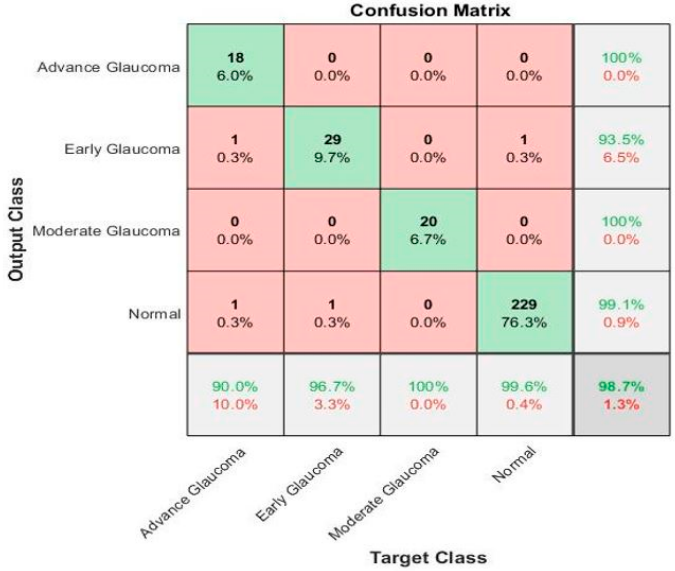
Figure 6. Confusion matrix of the 4-class glaucoma classification using the proposed ML-DCNN model on the Testing Dataset. Table 5. Computed Values (%) of Statistical Measures on the Local Retinal Glaucoma Image Dataset.